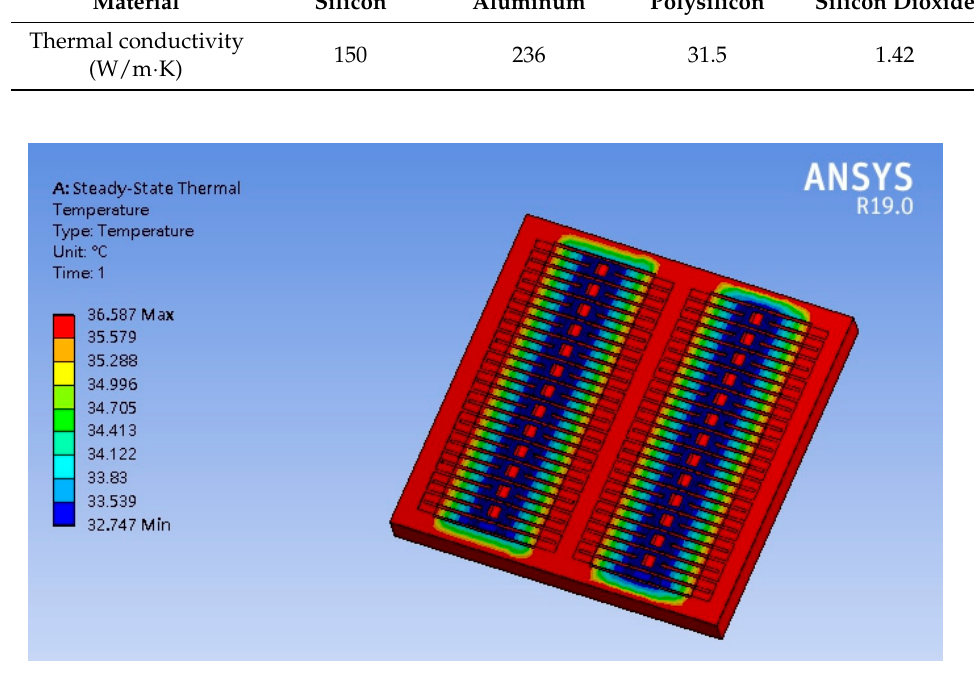
where m is thermocouple number, β 1 is the Seebeck coefficient of material-1, β 2 is the Seebeck coefficient of material-2, T ht is the hot part temperature of the thermocouple, and T cd is the cold part temperature of the thermocouple. According to Equation (1), the output voltage of the TEMH relies on the thermocouple number, TD ( T ht − T cd ), and the Seebeck coefficient difference ( β 1 − β 2 ). Increasing the thermocouple number could enhance the output voltage of the TEMH. The TD of the CHP of the thermocouple is proportional to the output voltage of the TEMH, so enhancing the TD could increase the TEMH output voltage. The Seebeck coefficient of the thermocouple materials is an important parameter. If both materials in the thermocouple show a large difference in the Seebeck coefficient, then the TEMH has a high output voltage. The Seebeck coefficient difference of thermocouples for the TEMH is 161 µ V/K [23]. The value is substituted into Equation (1) to compute the output voltage for the TEMH. Figure 3 shows the output voltage for the TEMH under different TD. The results showed that the output voltage for the TEMH enhances as the temperature difference increases, and the output voltage for the TEMH is proportional to the TD between the CHP of the thermocouples. As shown in Figure 2, the output voltage for the TEMH changes from 8.7 mV at a TD of 1 K to 34.8 mV at a TD of 4 K. The evaluation of the output voltage factor for the TEMH is 9.4 mV/mm 2 K.